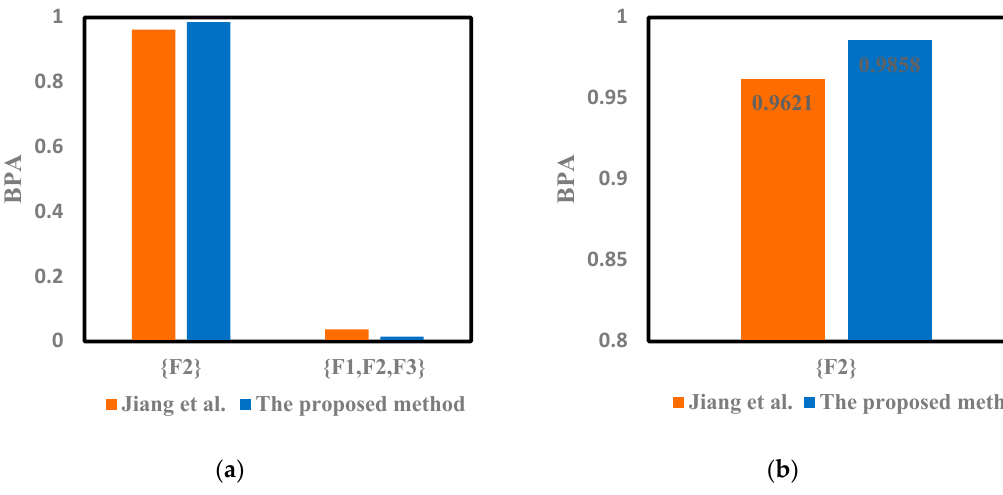
Sensors 2019 , 19 , x Figure 2. The comparison of different methods for motor rotor fault diagnosis at 1𝑋 frequency. ( a ) Figure 2. The comparison of di ff erent methods for motor rotor fault diagnosis at 1 X frequency. ( a ) Fusion results of different methods. ( b ) The result of { 𝐹 (cid:2870) } for 1𝑋 . Fusion results of di ff erent methods. ( b ) The result of { F 2 } for 1 X . Table 6. Fusion results of different methods for motor rotor fault diagnosis at 2𝑋 frequency.